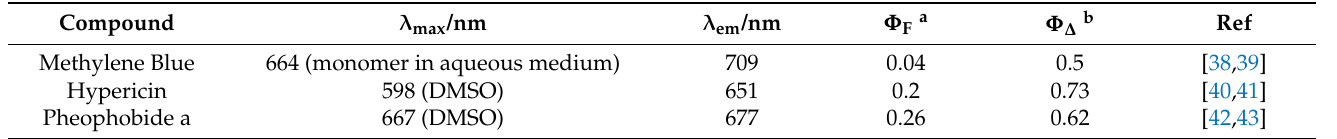
Table 1. Electronic absorption and basic photophysical data for 3 photosensitizers